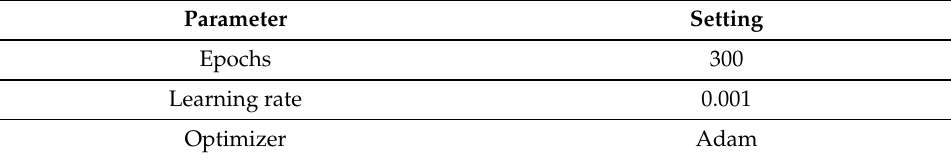
Table A2. Network